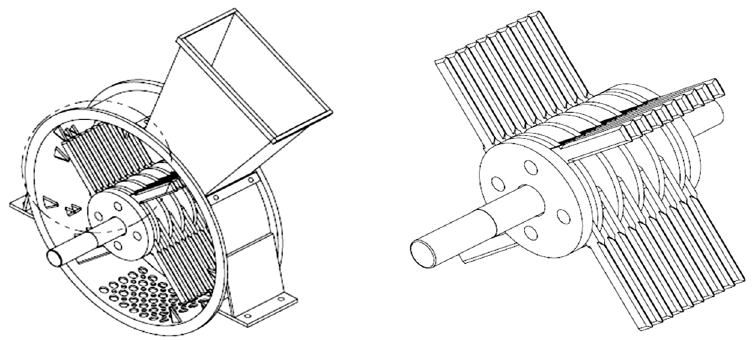
Figure 3. SolidWorks drawings of the shredder unit.